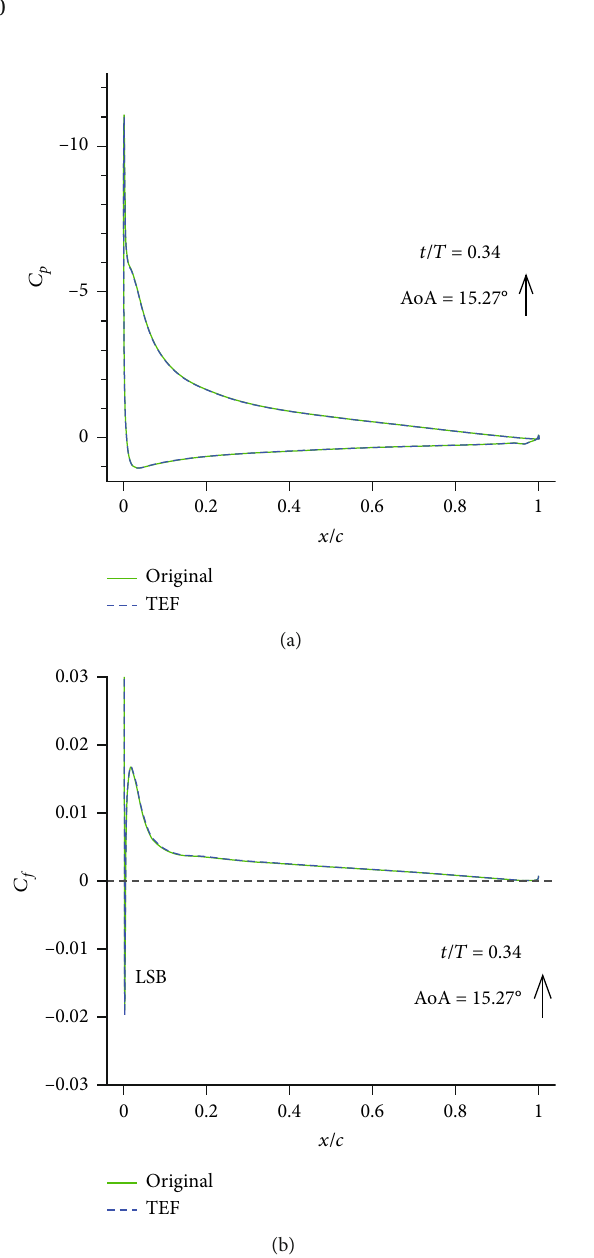
Figure 15: Comparison of coe ffi cient distributions at the angle of attack of 18.07deg upstroke: (a) pressure coe ffi cients and (b) skin friction coe ffi cients on the upper surface.